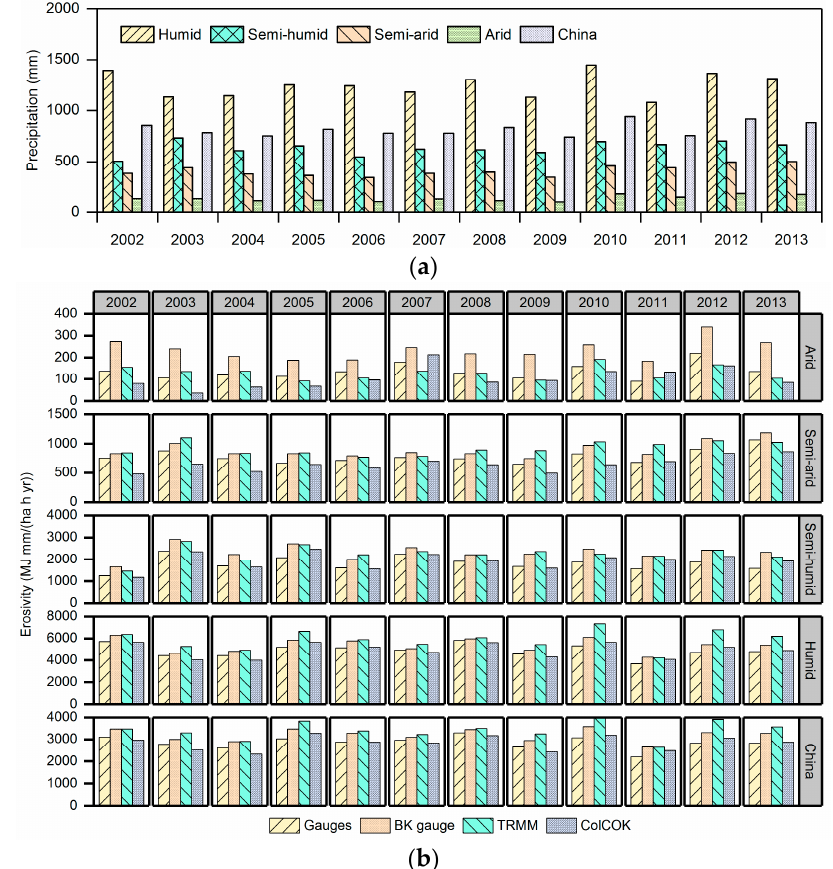
Figure 5. Temporal distribution of ( a ) annual precipitation and ( b ) rainfall erosivity in different climate regions and across the whole of China for 2002–2013. Table 3. Overall performance of validation results of the BK gauge-, TRMM-, and ColOCK-based yearly rainfall erosivity estimates in comparison with the 217 testing rain